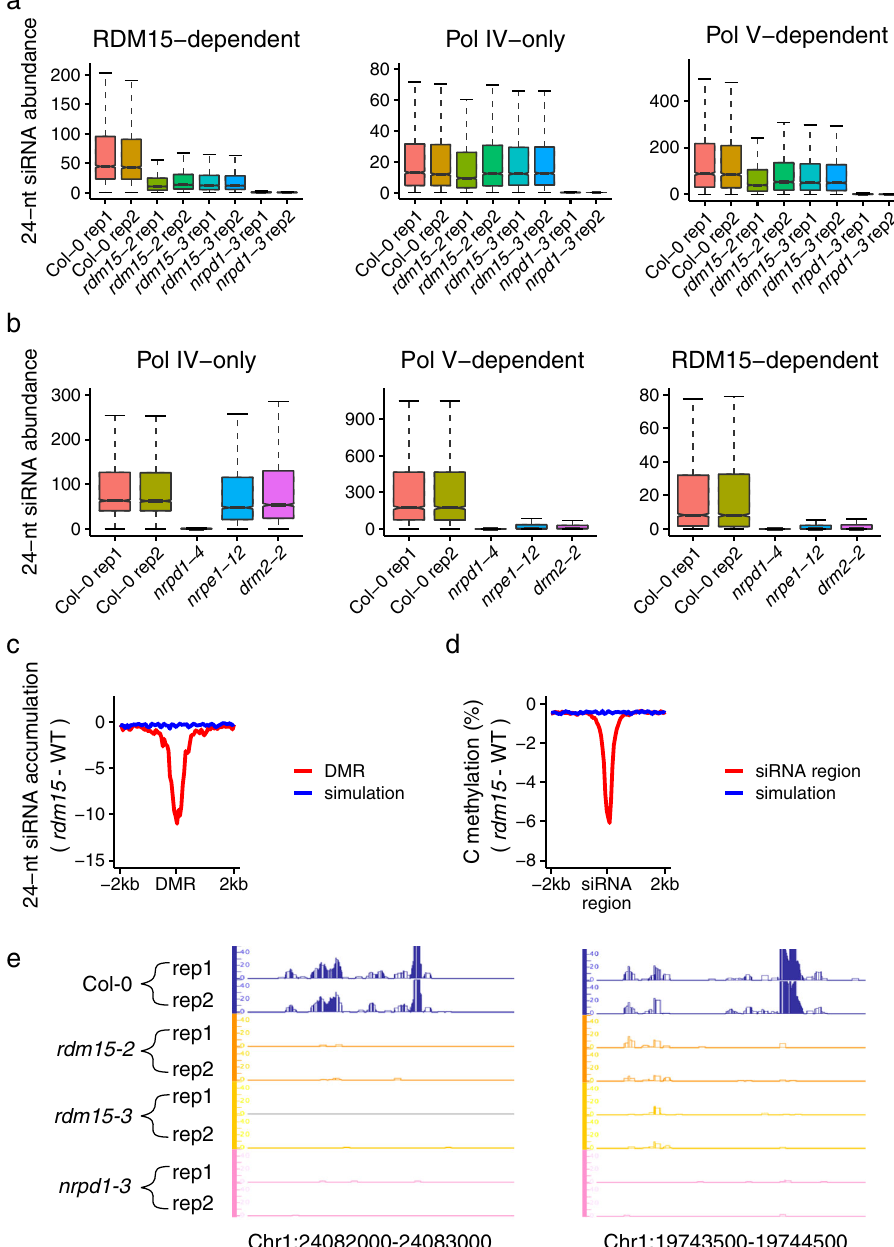
Fig. 3 Dysfunction of RDM15 abolishes RdDM-dependent 24-nt siRNA accumulation. a Boxplots showing the abundance of 24-nt siRNAs in Col-0, rdm15-2 , rdm15-3 , and nrpd1-3 with two replicates. The siRNA levels of RDM15-dependent siRNA cluster regions (left), Pol IV-only siRNA cluster regions (middle), and Pol V-dependent siRNA cluster regions (right) are shown. Compared to Col-0, RDM15 siRNAs were decreased in rdm15 and nrpd1-3 mutants, whereas Pol IV-only siRNAs (upstream RdDM siRNAs) were decreased in nrpd1-3 but not in rdm15 . b The abundance of 24-nt siRNAs is shown for Pol IV- only, Pol V-dependent, and RDM15-dependent siRNA regions in Col-0, nrpd1-4 , nrpe1-12 , and drm2-2 . Pol IV-only and Pol V-dependent siRNAs represent upstream and downstream RdDM siRNAs, respectively. c Changes in 24-nt siRNA enrichment in rdm15 relative to WT at rdm15 hypo DMRs. d Changes in DNA methylation level, including mCG, mCHG, and mCHH, in rdm15 relative to the WT at RDM15-dependent siRNA cluster regions. e IGB display of siRNA abundance of two RDM15-dependent siRNA regions in Col-0, rdm15-2 , rdm15-3 , and nrpd1-3 . Two replicates are